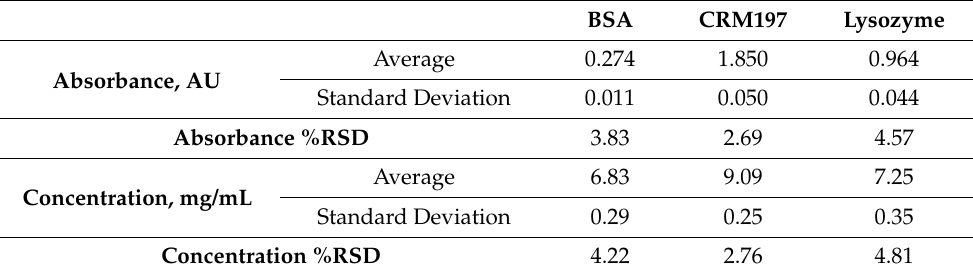
Table 1. Average value, standard deviation and %RSD for the proteins when analyzed with UV-Vis spectrophotometer in low adsorption conditions (without ammonium sulfate).